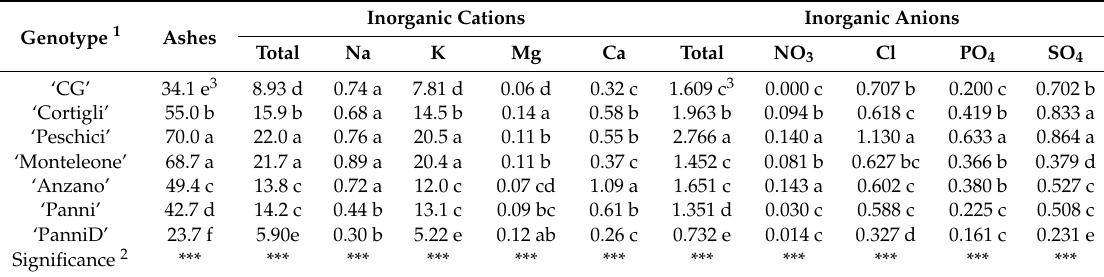
1 Refer to Table 1 for acronyms of garlic genotypes. 2 *** Significant at p ≤ 0.001. 3 Di ff erent letters within the column indicate significant di ff erences at p =